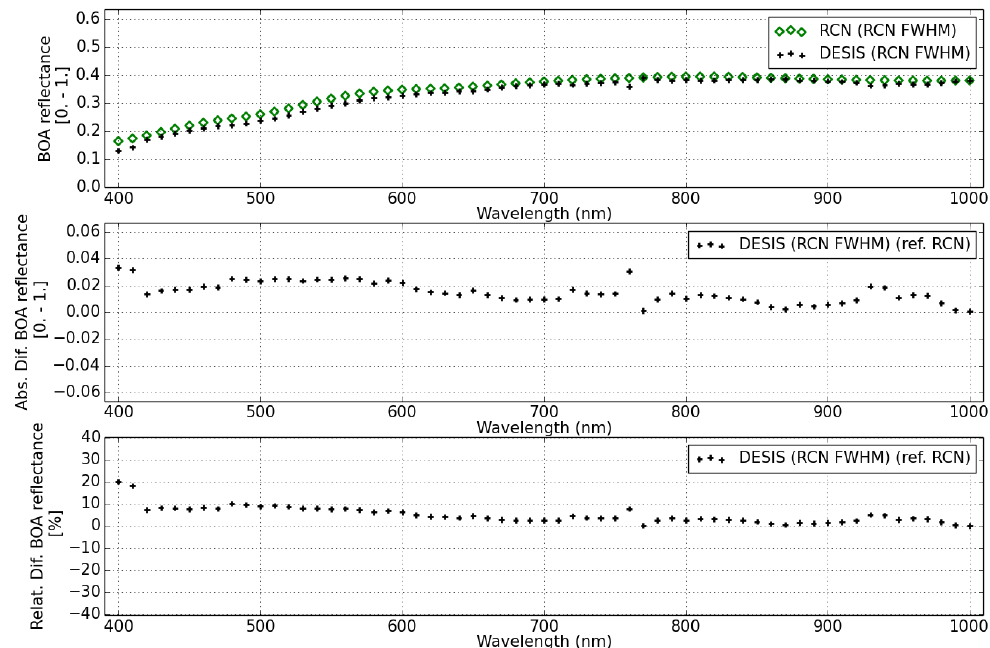
Figure 26. DESIS (black crosses) and RadCalNet (green diamonds) BOA surface reflectances at 10 nm spectral resolution for Railroad Valley Playa site (28 June 2019). For each of the set of plots: ( top ) BOA surface reflectance; ( center ) absolute difference of surface reflectance; and ( bottom ) Relative difference (%) of surface